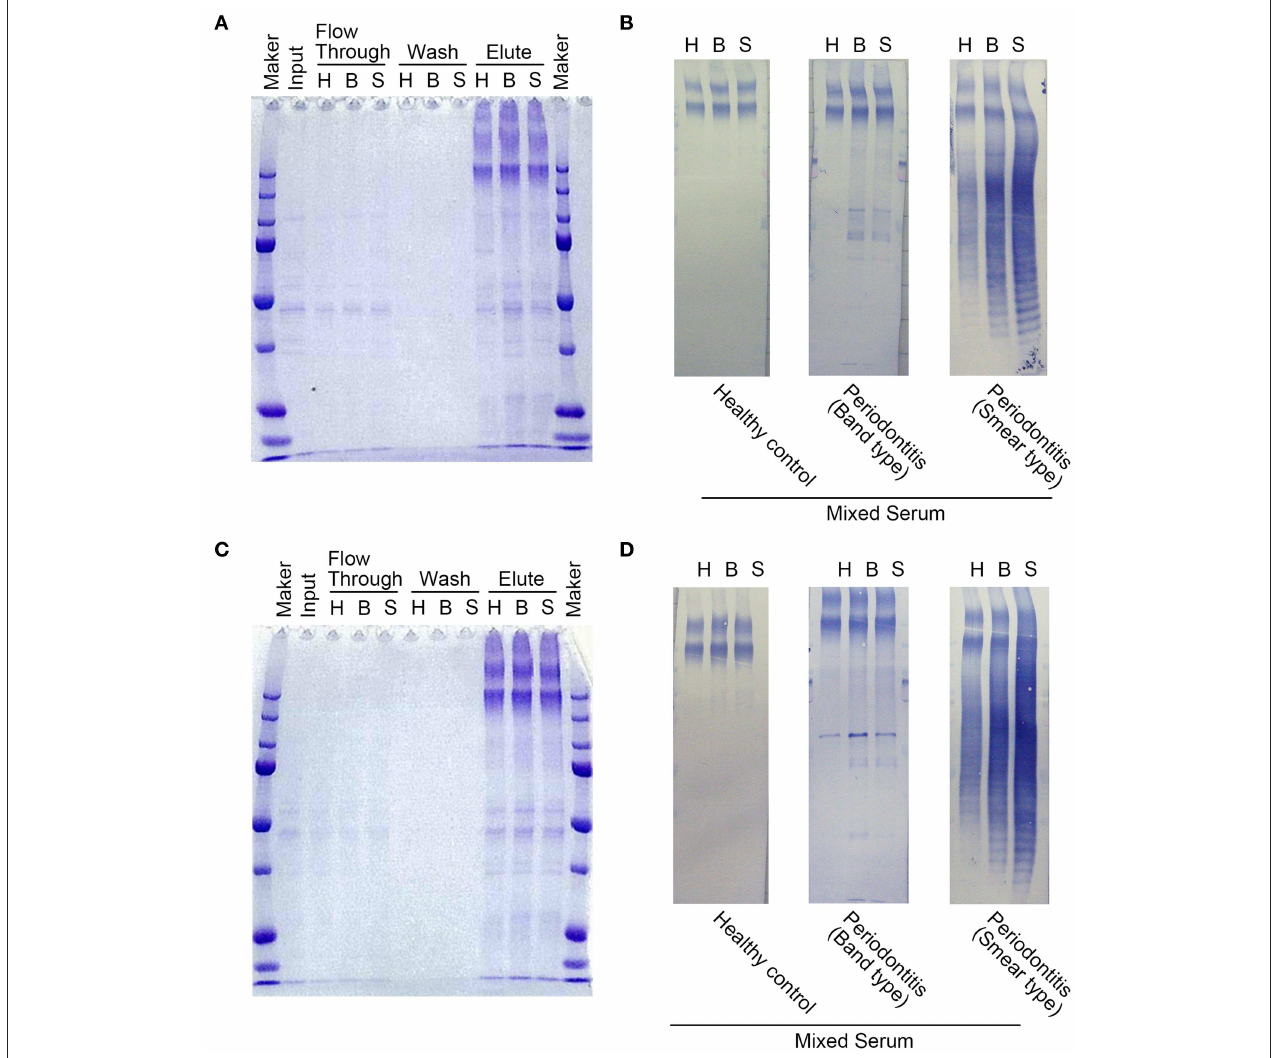
FIGURE 1 | Protein contents in various fractions after purification using immunoaffinity columns. SDS-PAGE was used to separate the proteins from each fraction for strains FDC381 (A) and SU63 (C) . 10 µ L of each fraction were loaded into each gel lane. Immunoreactivities of the separated proteins in the elutes for strains FDC381 (B) and SU63 (D) were confirmed by Western blot analysis with mixed serum used in the immunoaffinity columns as described in Supplementary Figure 2 . Approximately, 2 µ g of each protein was blotted on the membrane, and pooled sera used for affinity column (three subjects in each) were used at a dilution of 1:2,500. H: healthy control, B: the serum type of clear bands, S: the serum type of smear